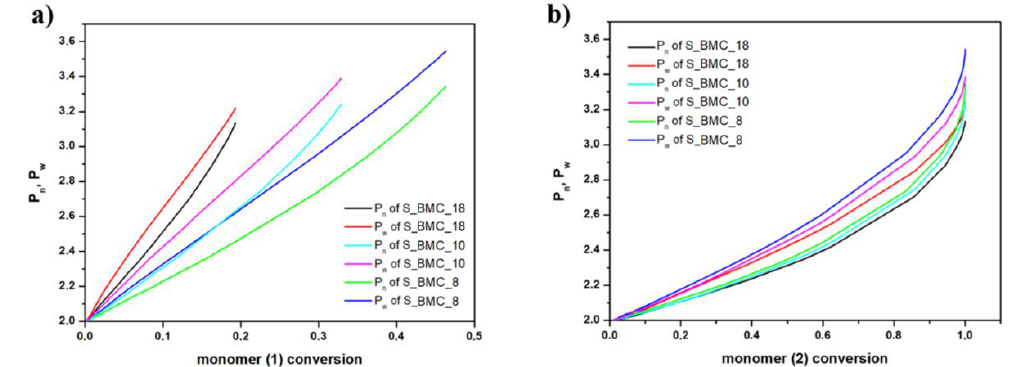
Figure 13. DLL simulation of ( a ) the growth of number average chain length (P n ) and weight average (P w ) with DMC ( b ) and 1,10-decanodiol conversions.